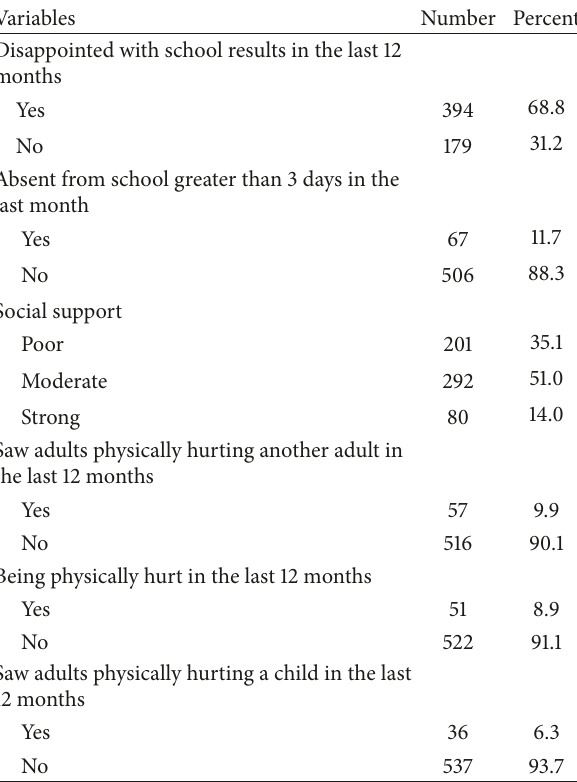
Table 2: Frequency distribution of psychosocial factors among ado- lescent high school students in Dangila Town, Northwest Ethiopia,